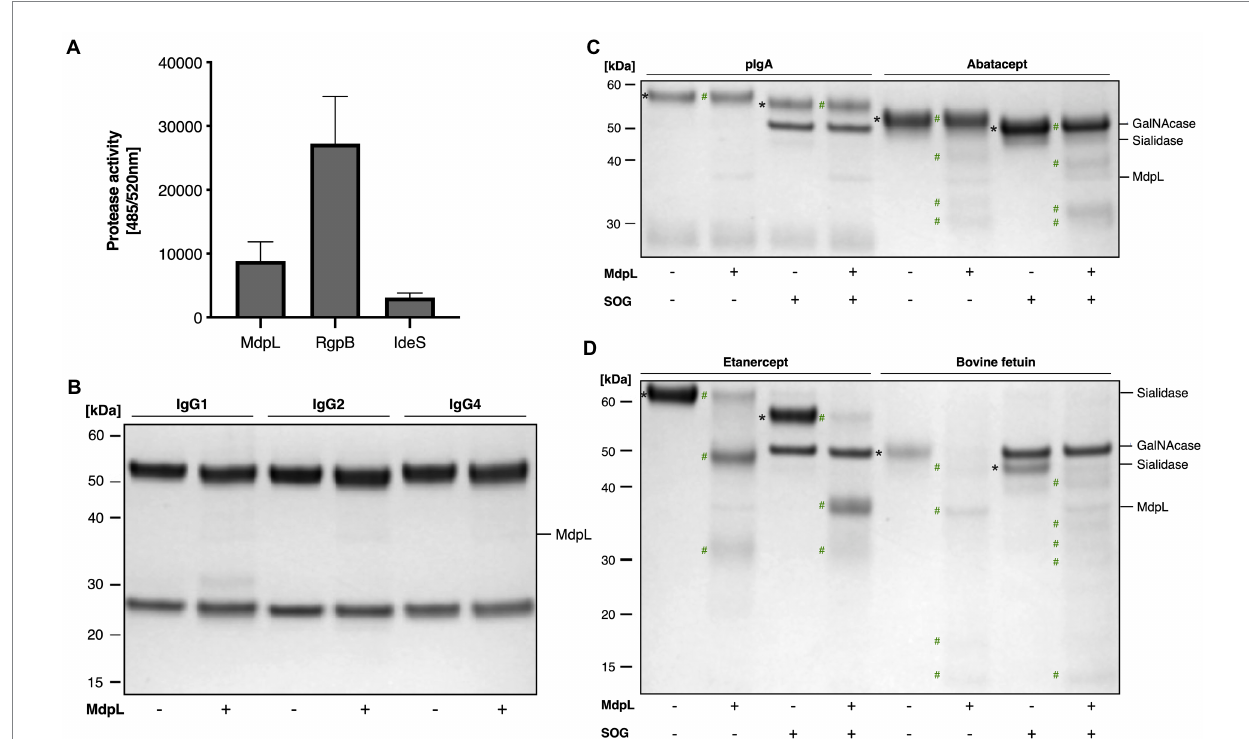
FIGURE 3 Proteolytic specificity and absence of O-glycan dependence of MdpL. MdpL activity toward (A) fluorescently labeled casein; RgpB (Arg-specific) and IdeS (IgG-specific) were included as controls, (B) human IgG subclasses, ( C,D ) O-glycoproteins with or without Core 1 O-glycans. SOG depicts the glycan hydrolyzing enzymes Sialidase, O-glycosidase, and α -GalNAcase. Assay (A) was conducted using the fluorescence based EnzChek Protease Assay. Protein substrates in Assays (B–D) , including IgG1, IgG2, IgG4, pIgA, Abatacept, Etanercept, and bovine fetuin were incubated with MdpL (37 ° C, 18 h) and analyzed using SDS-PAGE under reducing conditions. Intact and deglycosylated substrates (*), and MdpL-generated fragments (#). MdpL and SOG reference bands can be found in Supplementary Figure